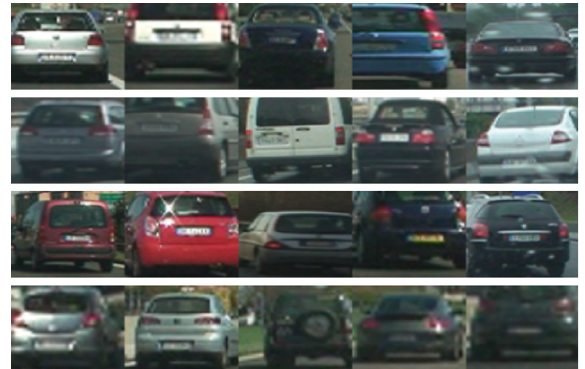
Figure 9: Some vehicle training sample